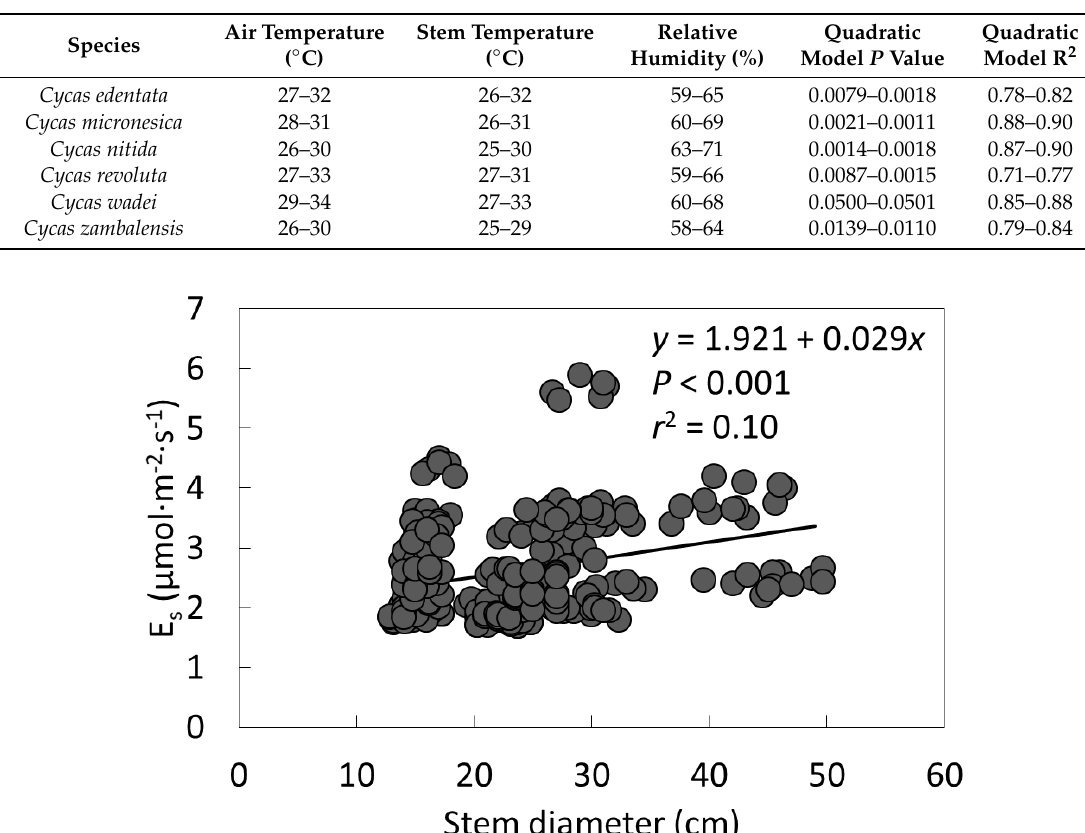
Table 1. Characteristics of the six study locations used for Cycas stem carbon dioxide e ffl ux measurements. Range of six replications.